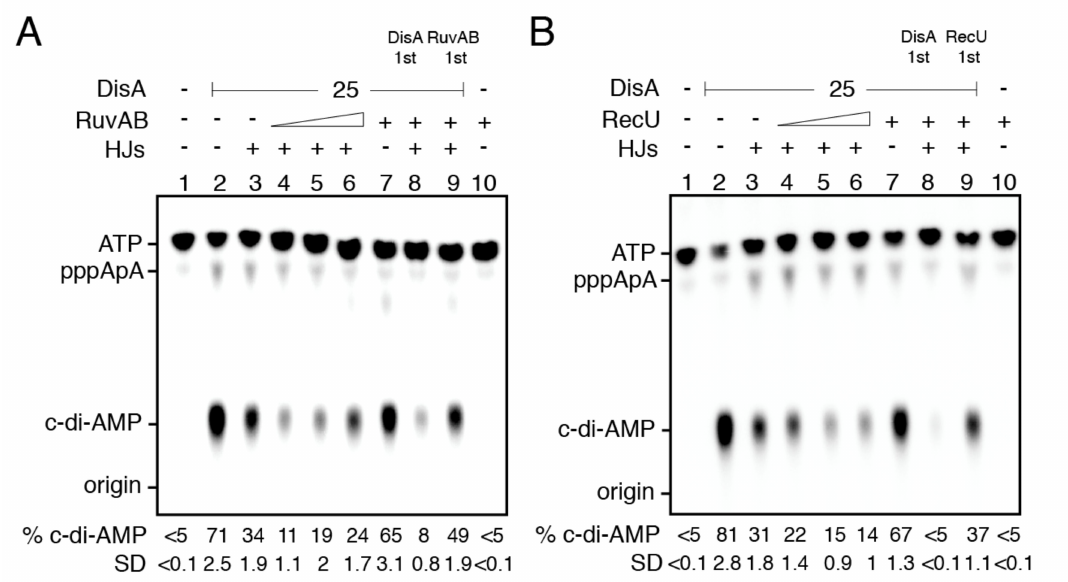
Figure 6. HJ DNA and RuvAB or RecU inhibits DisA-mediated c-di-AMP synthesis. ( A , B ) A fixed DisA concentration was incubated alone (lane 2), with HJ DNA (125 nM) (lane 3), increasing RuvAB ( A ) or RecU ( B ) concentrations (7, 15, or 30 nM) and HJ DNA (lanes 4–6), or with RuvAB ( A ) or RecU ( B ) (30 nM, lane 7) in buffer D containing 100 µ M ATP (at a ratio of 1:2000 [ α 32 P]-ATP:ATP) and 10 mM MgCl 2 (30 min at 37 ◦ C). In lane 8, DisA was pre-incubated with HJ DNA (5 min at 37 ◦ C) and then a fixed concentration of RuvAB ( A ) or RecU ( B ) and ATP were added, and the reaction incubated (30 min at 37 ◦ C). In lane 9, RuvAB or RecU was pre-incubated with HJ DNA and then DisA and ATP were added, and the reaction was incubated (30 min at 37 ◦ C). In lane 10, a control reaction with only RuvAB or RecU (30 nM) is shown. The substrates and products were separated by TLC, and the spots quantified. The position of ATP, linear pppApA, c-di-AMP, and the origin are indicated. At least three independent experiments were performed, a representative plate, and the mean % of c-di-AMP produced and its SD are